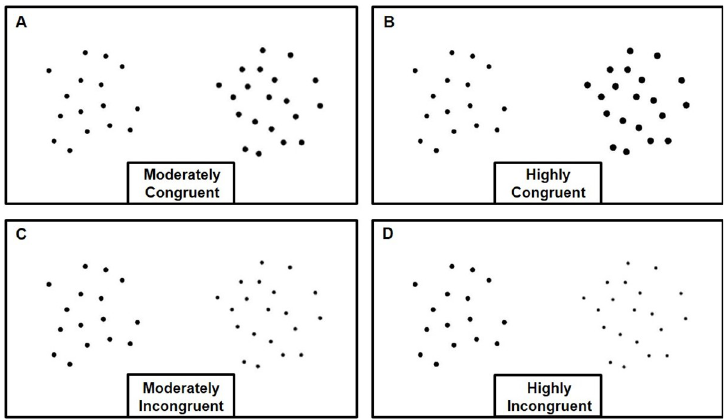
Fig 1. Example stimuli (16 vs. 20) of each condition of the Numerosity Comparison